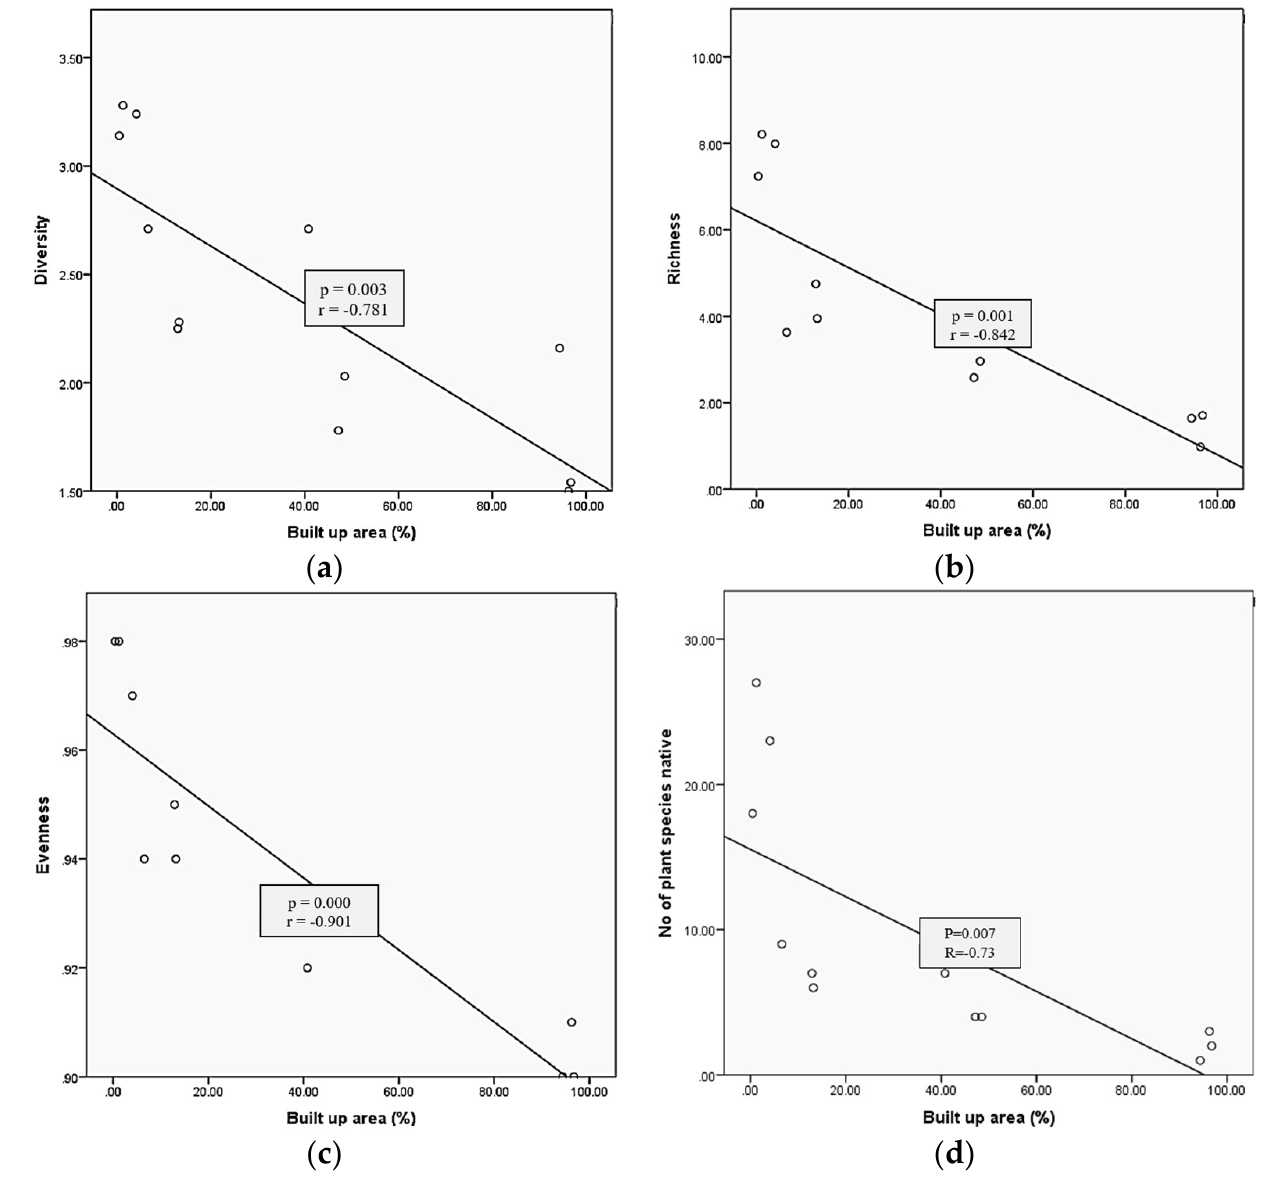
Figure 2. Relationships between the percentage of built-up area and ( a ) plant diversity; ( b ) plant richness; ( c ) plant evenness; and ( d ) plant native (species). Table 3. Multiple comparisons on the number of native species in urban, suburban, rural, and wildland areas in Ipoh, Perak, Malaysia. Figure 3c; air humidity: r = − 0.859, p < 0.01, Figure 3d; and light intensity: r =